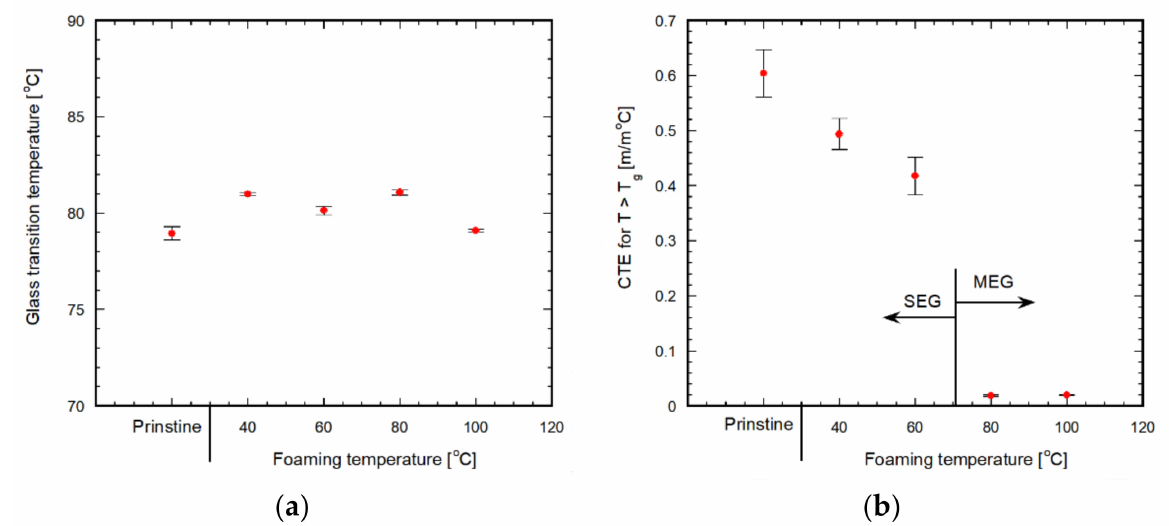
Figure 6. Effects of PET–PEN foaming temperature on ( a ) glass transition temperature; ( b ) coefficient of thermal expansion (CTE) for T > T g . Vertical lines represent error bars.